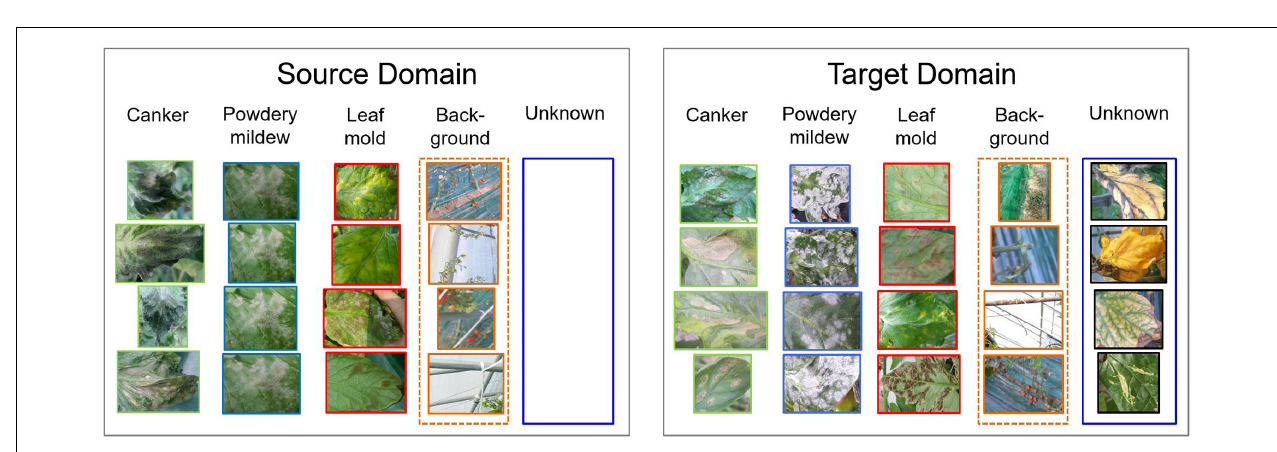
FIGURE 2 | Traditional Open Set vs. Open Set for Plant Diseases. The first one (A) contains a universe of data that can be part of the known categories or unknown otherwise. However, in the task of plant diseases (B) , we further consider the following conditions: (1) The source where the data has been collected (farm), and (2) the plant states, such as the presence of diseases that can be different at each site. ? represents the unknown data. The dotted boxes represent the portion of data used for training (inside the box) and testing (outside the box) respectively.